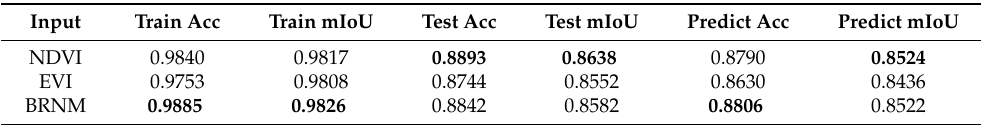
Table 5. The results of different satellite-derived metrics and combinations of reflectance bands for crops SPM.